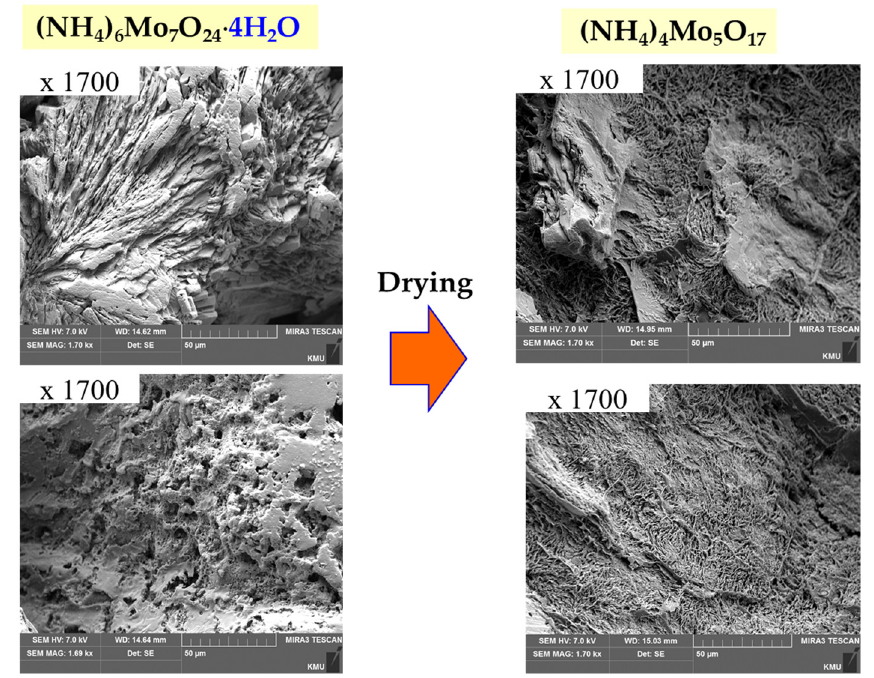
Figure 4. SEM images of ammonium molybdates before and after drying (at 90 °C for 720 min).